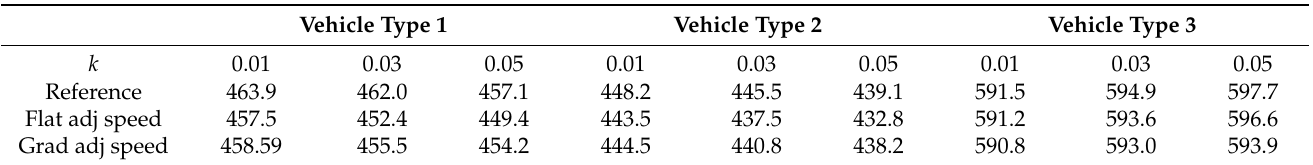
Table 7. Total energy consumption (Wh) under alternative speed profiles, gradient assumptions, and vehicle types (symmetric hill, WMTC Reference Cycle 2).